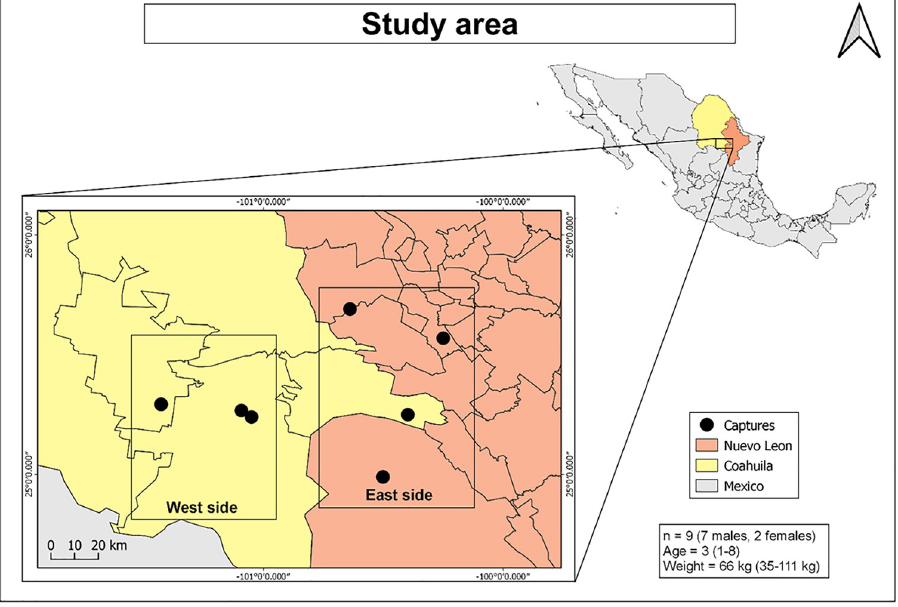
Fig 1. Study area. Coahuila (yellow) and Nuevo Leon (orange) states. In the lower right corner, information about the study population: sample size (n), median and range of age and weight. The figure was made in QGIS 3.10.10 suite (with CC BY 4.0 license) and loaded with INEGI (Instituto Nacional de Estadı´stica y Geografı´a).